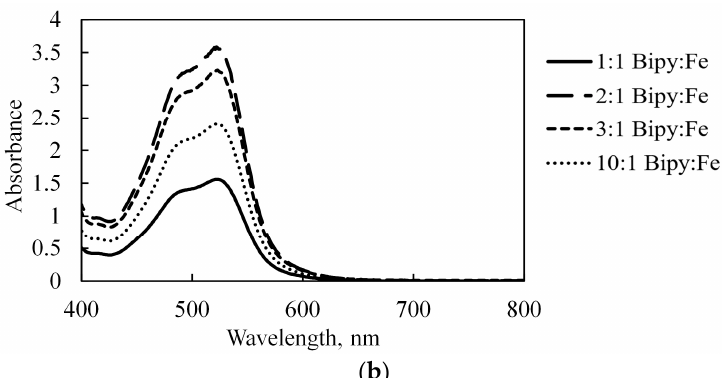
Figure 3. Absorption spectra of ( a ) Bipy:Cu and ( b ) Bipy:Fe samples of different mole ratios in nitric acid.